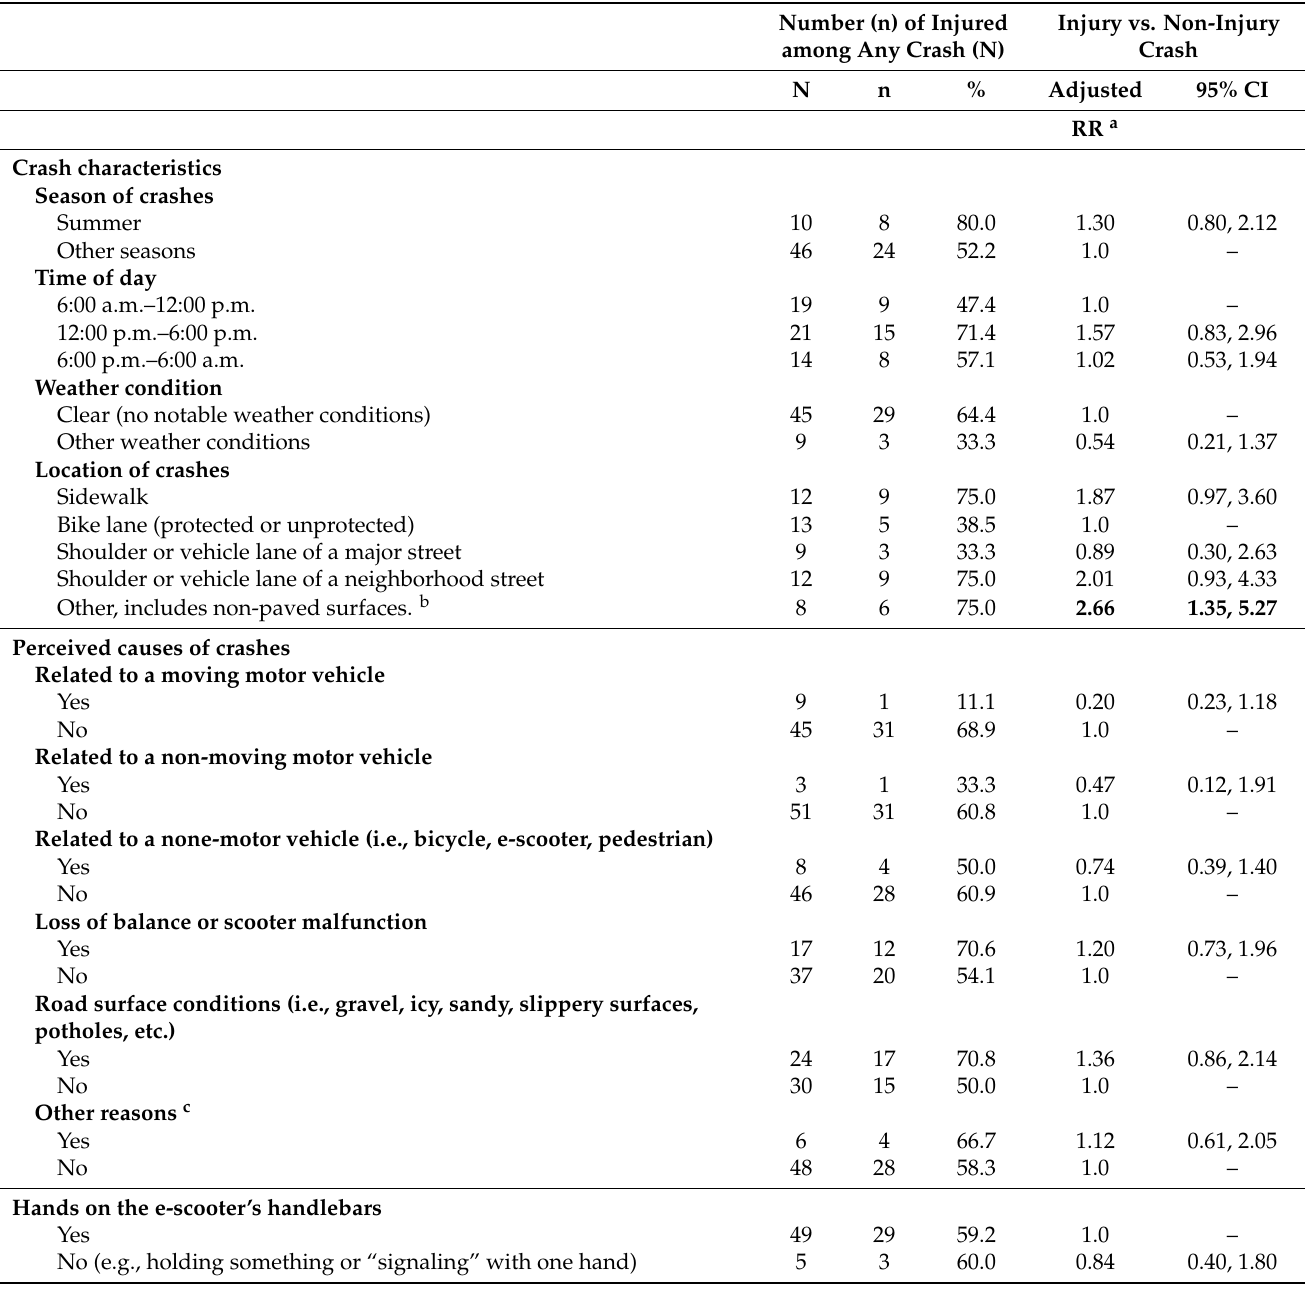
Table 3. Associations between crash-level factors and e-scooter related injury and non-injury crashes.